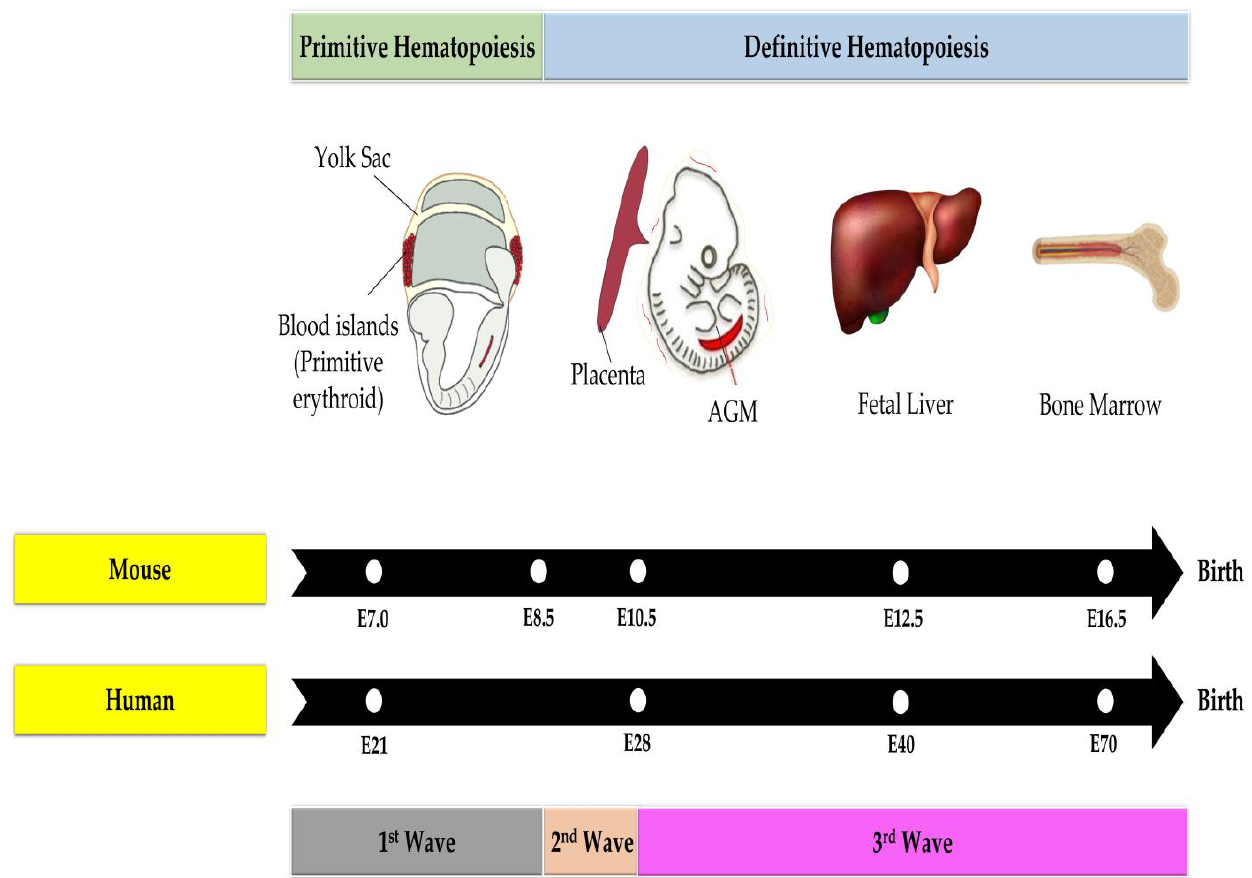
Figure 1. Hematopoiesis in fetal phase for mouse and human. Abbreviations: AGM: aorta-gonad- mesonephros; E: embryonic day.